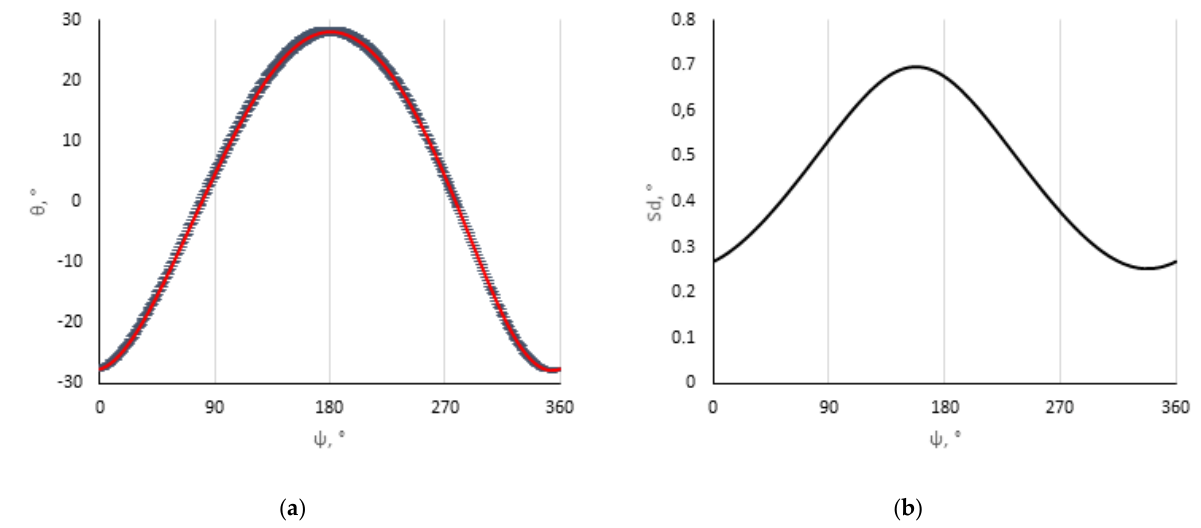
( b ) Figure 7. Curve illustrating : ( a ) values of composite quantity θ , together with standard measuring uncertainty due to the measurement of L . ( b ) standard measuring uncertainty values for composite quantity θ due to the measurement of L .